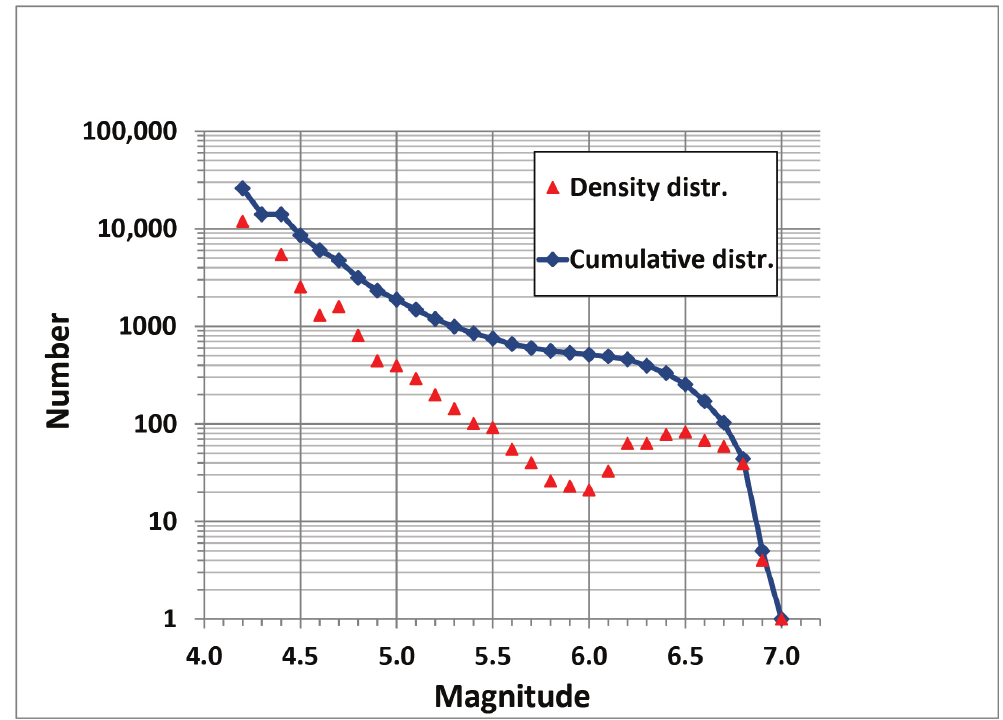
Figure 2. Incremental magnitude–frequency distribution of the earthquakes in the synthetic catalogue obtained from the simulation algorithm (triangles) and the corresponding cumulative distribution